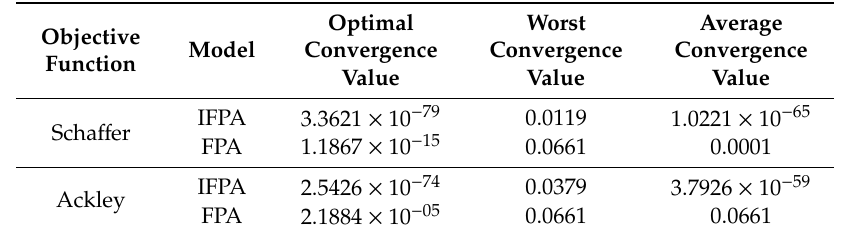
Table 4. Test results.